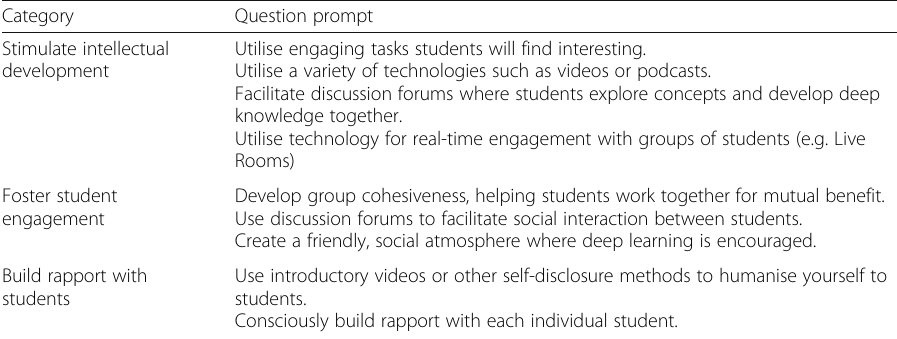
Table 11 Approach two for identifying conceptions of teaching and enacted practice. Nine student-centred indicators developed from Bain ’ s ‘ what the best teachers do ’ (Bain, 2004) adapted to online education by Brinthaupt et al.